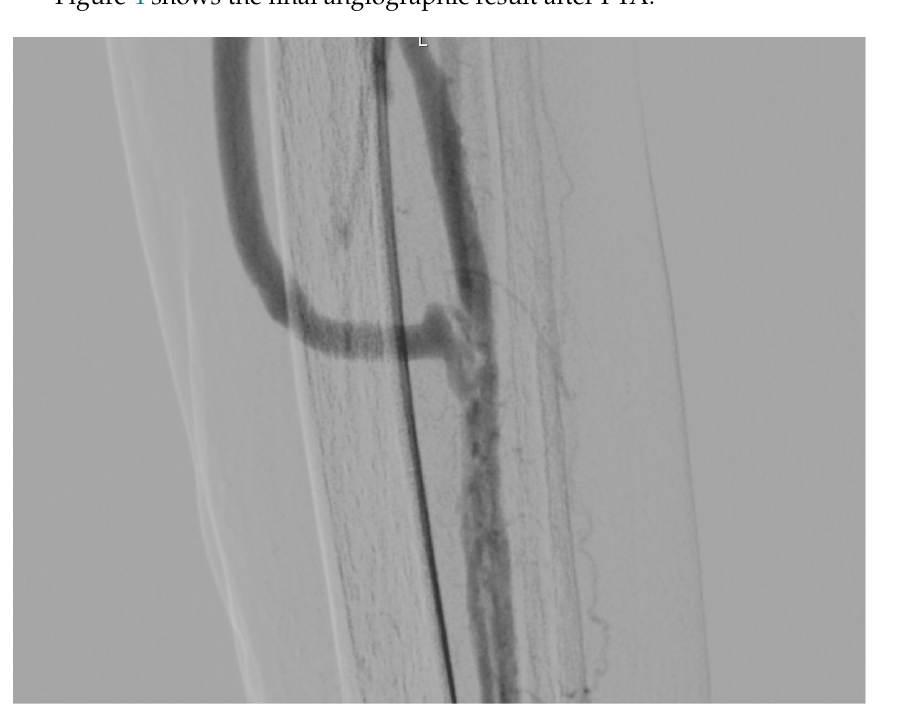
Figure 4. Angiography frame of the distal anastomosis on the peroneal artery.